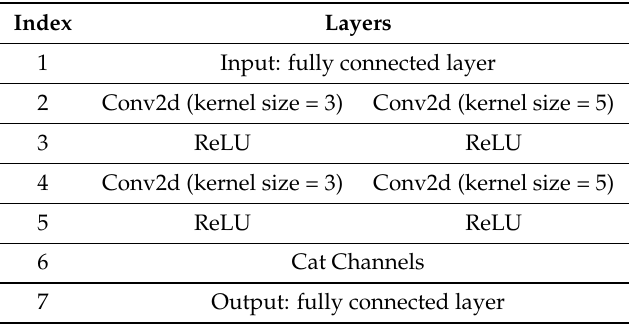
Table A2. The Structure of Enhanced Multi-scale Combined Convolutional Neural